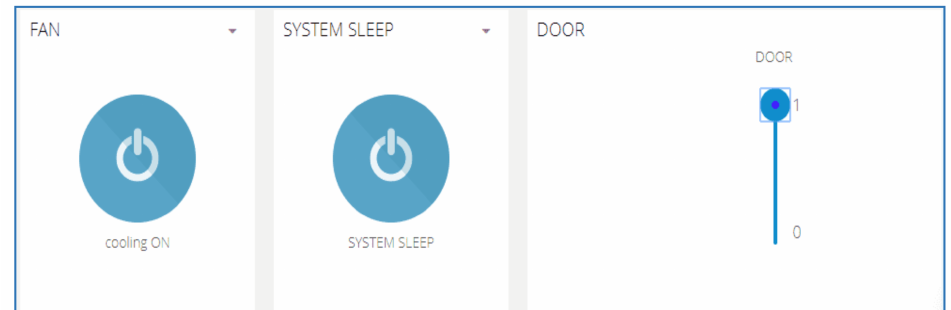
Figure 22. Control buttons in the mobile application of